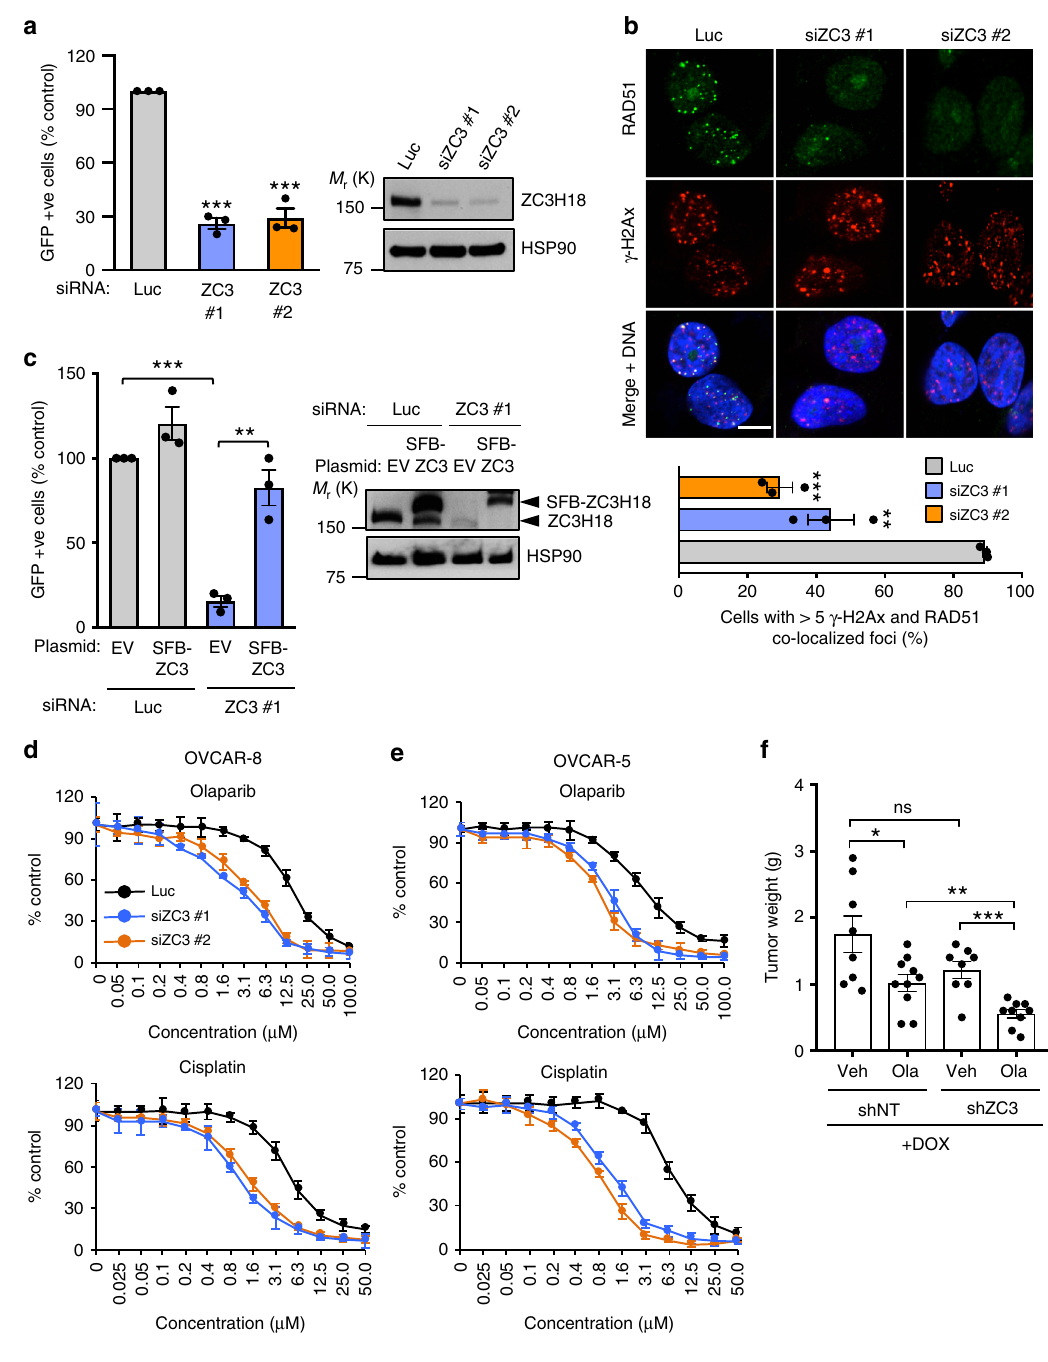
ZC3H18-depleted cells with the DNA methylation inhibitor without affecting ZC3H18 mRNA levels (Fig. 3c, d), demonstrat- ing that BRCA1 promoter methylation induced by ZC3H18 depletion reduces BRCA1 expression.